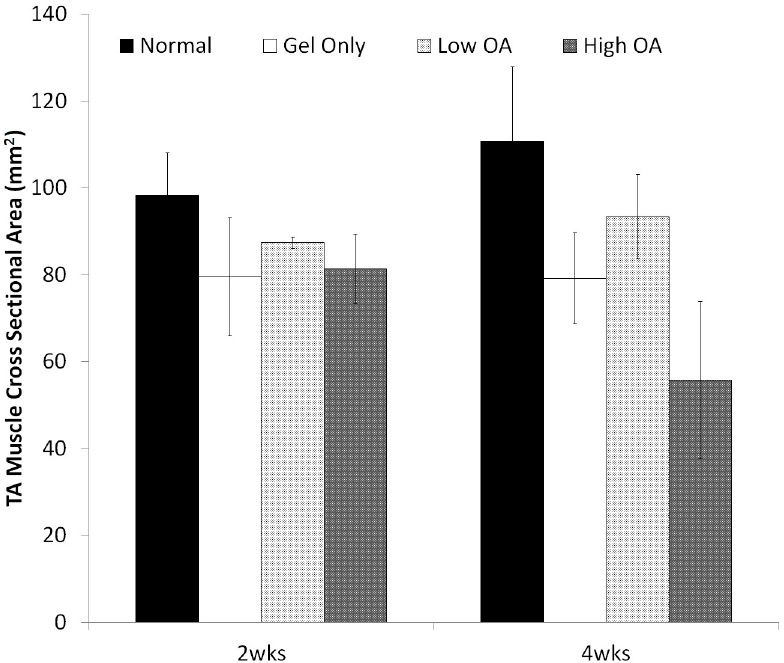
Fig 7. Measurements of TA muscle CSA at the step-level section located 5.5 mm deep from the anterior edge of the muscle at 2 weeks and 4 weeks. At 2 weeks the CSA of the TA muscles in the no treatment (gel only) and OA treatment groups was decreased to 63–93%of the CSA of the TA muscle from an age and gendermatched normal rat at the same step-level. At 4 weeks the CSA of the TA muscles in the no treatment (gel only) and OA treatment groups was similarlydecreased to 60–90%of the CSA of the TA muscle from an age and gendermatched normalrat at the same step-level.